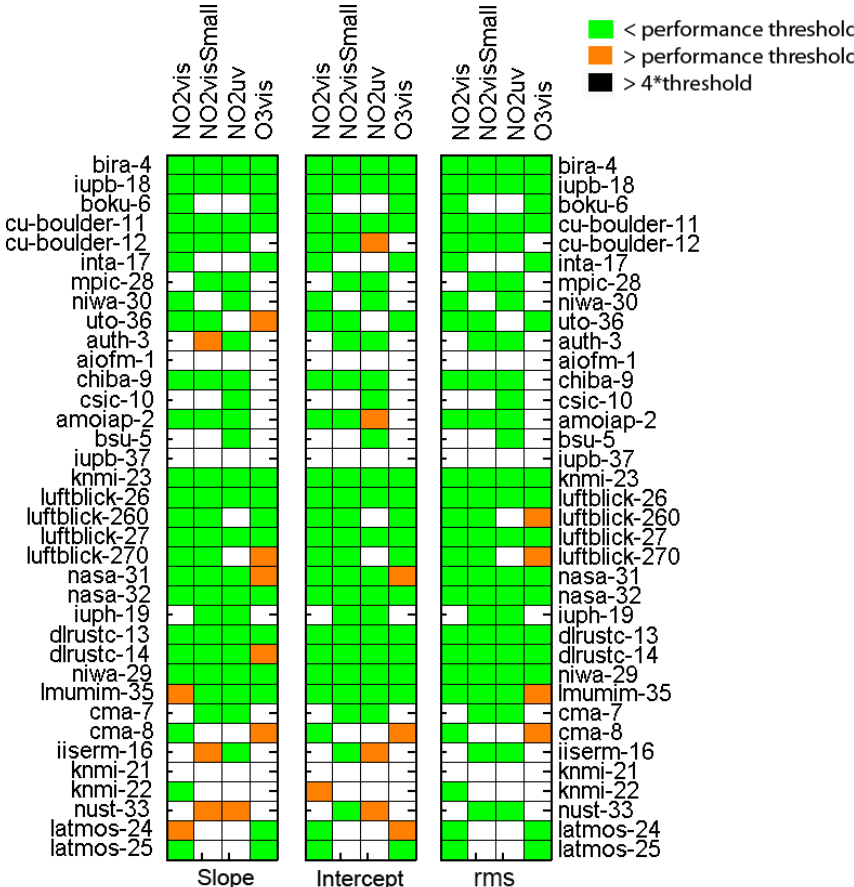
Figure 21. Same as Fig. 20 but for the zenith-sky